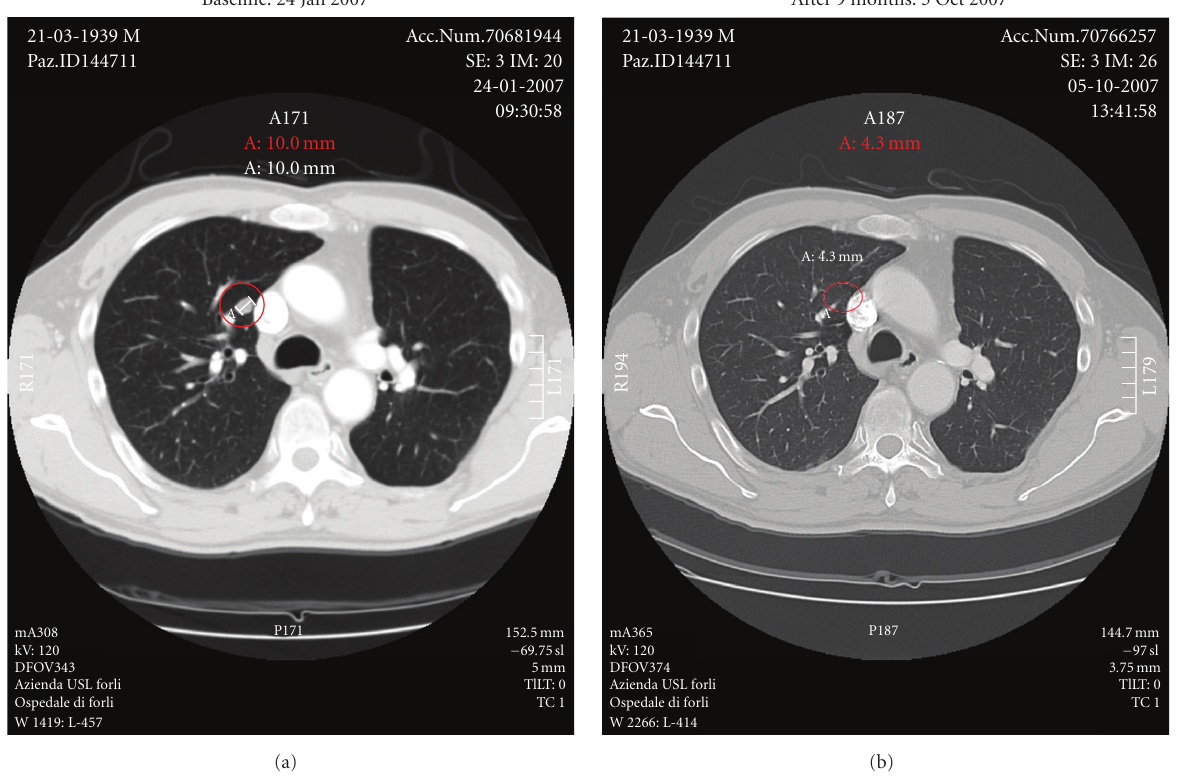
Figure 1: CT scan of patient n. 25 (BI) before and at the end of vaccination cycles. The red circle indicates the PR observed to vaccine. The patient underwent palliative surgery following progression in adrenal gland and abdominal lymph node metastases after stopping vaccination and has ongoing PR in the